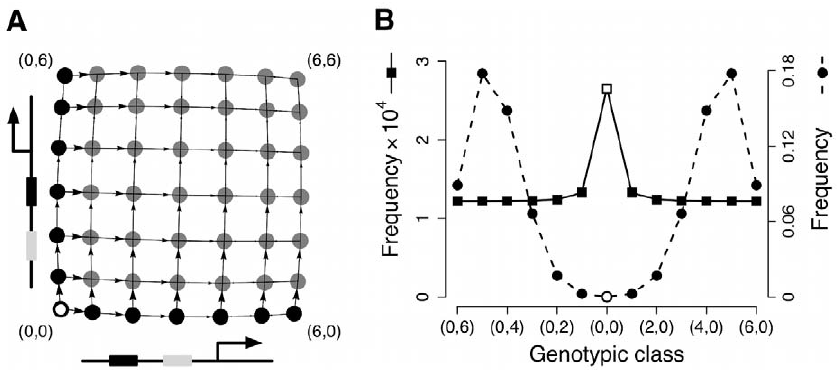
Figure 3. Condensed mutational networks for a promoter with K ~ 2 binding sites (both with length n ~ 6 ). (A) Axes represent the Hamming distance of each binding site from the canonical sequence ( m 1 , m 2 ) . Each node represents a genotypic class. At each condensed genotypic (cid:6) class ( m 1 , m 2 ) there are 3 m 1 genotypes. The magnitude of the probability of transition between two genotypic classes is denoted by the length of the arrowheads. In this example, the promoter regulates an essential gene such that at least one canonical binding site is required for activity (see Equation 4). The nodes in black define the viable portion of the condensed mutational network. The open circle denotes the redundant genotype. The nodes in gray represent inviable genotypes. (B) Shows the equilibrium distribution over the viable portion of the condensed mutational network. Squares (solid line, left axis) show the average frequencies of each genotype in a genotypic class; circles (dashed line, right axis) show the sum of the frequencies of all genotypes in a genotypic class. The redundant genotype (0,0) is shown in an open symbol, all other (nonredundant) genotypes are represented by closed symbols.